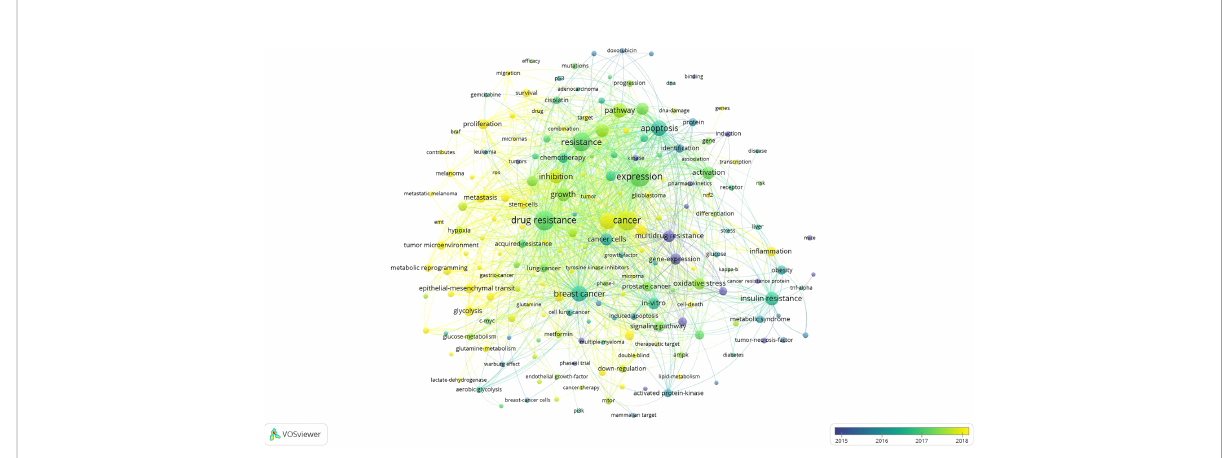
FIGURE 5 Overlay visualization map of keyword co-occurrence analysis. The node and label meanings in this map are the same as in the network visualization map. Furthermore, the color of a node indicates the APY of each keyword according to the color gradient shown in the lower right